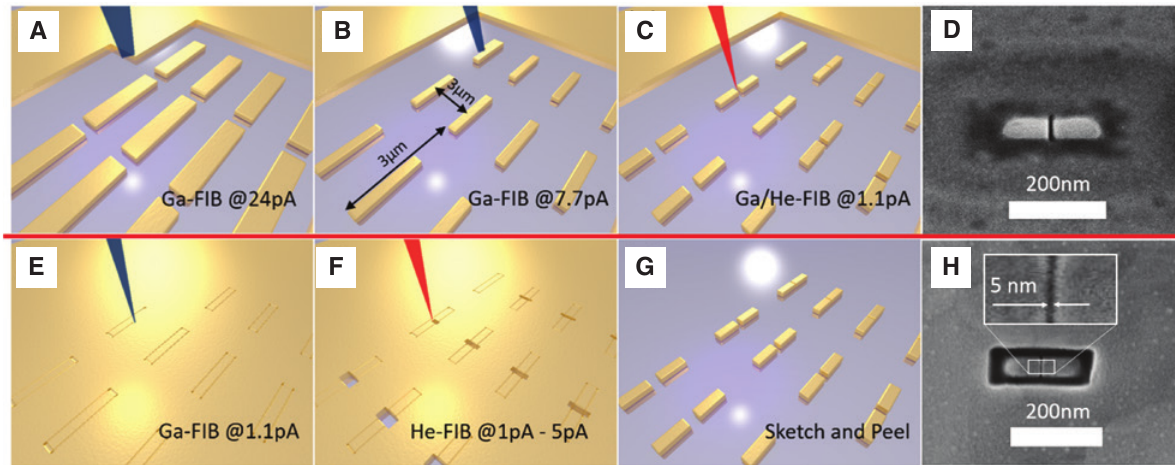
Figure 1: Schematics of the plasmonic nanorod dimer fabrication processes. (A–C) Ga and Ga/He lithography to produce dimer antennas with gap distances of down to 6 nm. (D) Scanning electron micrograph of a single nanorod with a gap size of 6 nm. (E–G): sketch and peel (SaP)–based fabrication process. (E) The outline of the nanostructures is milled using a Ga + -ion beam at low current. (F) In a second step, the He-FIB is used to fabricate gaps with distances of down to 5 nm. (G) An adhesive tape is used to selectively remove the outer regions of the nanostructure. (H) Helium-ion micrograph of a prototypical dimer antenna after the He-FIB process with a gap size of 5 nm before the SaP